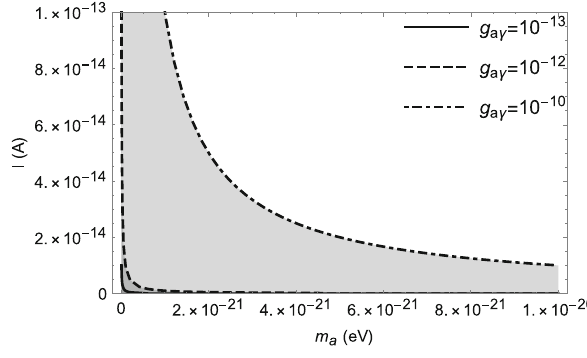
Fig. 4 I vs m a for fixed g a γ [85]. The limits of the current are pro- vided by the regions below the continue and dashed lines (grey regions) corresponding to the different values of the coupling constant g a γ . Pos- sibilities to measure small currents have been discussed in